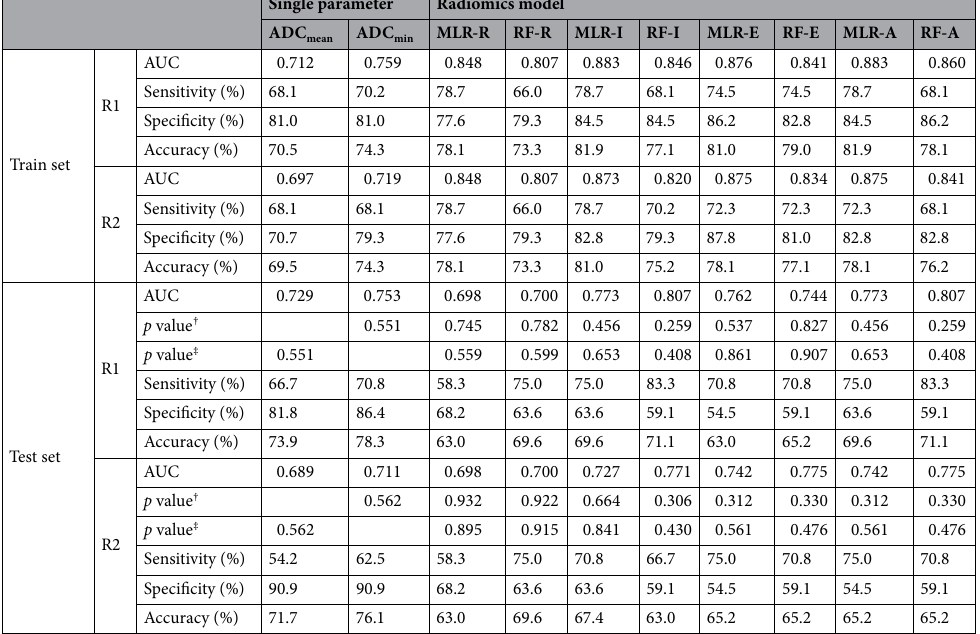
Table 3. Diagnostic performance of ADC mean , ADC min and radiomics model in training set and test set. R1 Reader 1, R2 Reader 2. † p value calculated from Delong test for comparison of diagnostic performance between radiomics model and ADC mean in test set. ‡ p value calculated from Delong test for comparison of diagnostic performance between radiomics model and ADC min in test